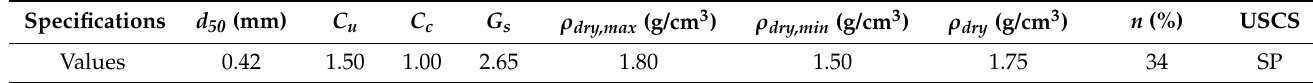
Figure 1. Grain size distribution (GSD) of Sebilco 30/60 sand. Table 1. Grading analysis for GSD of selected medium sand and density control in soil columns.